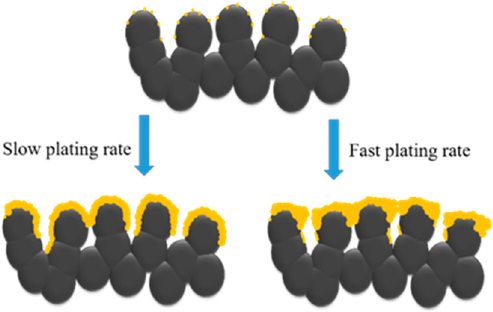
Figure 5. Schematics illustrating the stacking behaviors of Pd with slow and fast plating rates.